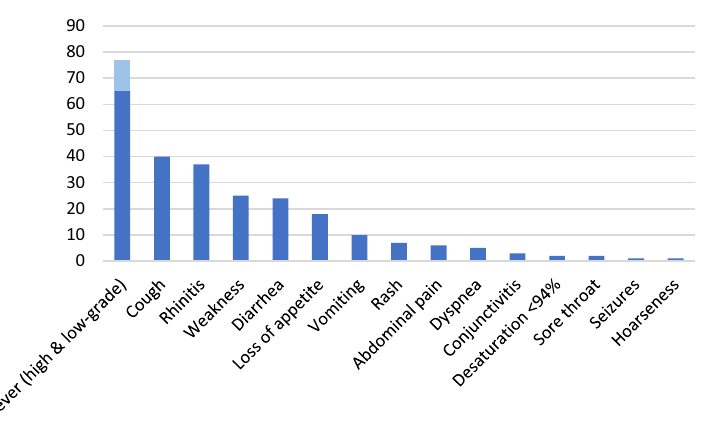
Figure 2. Clinical symptoms of COVID-19 in 300 infants. Data are presented as prevalence of the symptoms diarrhea in 73 (24%), loss of appetite in 55 (18%), vomiting in 29 (10%), rash in 21 (7%), abdominal pain in 18 (6%), and dyspnoea in 16 (5%) (Fig. 2). Severity of disease was classified as mild 276 (97.9%), moderate 6 (2%), and severe 0. An asymptomatic course was recorded in 32 (11%) patients. Comorbidities were reported in 12% of infants, including congenital disabilities, epilepsy, prematurity, atopic dermatitis, bronchopulmonary dysplasia, and immunodeficiency (Table 1). In the analyzed laboratory test deviations, 52% (74/141) of the patients had an elevated concentration of D-dimers > 500 ng/mL, and 40% (32/80) of the cases had an elevated concentration of Interleukin-6 (IL-6) > 7 pg/ mL. Antipyretic drugs were used in 115 (38%) patients, including paracetamol in 62 (54%), ibuprofen in 12 (10%), and a combination of paracetamol and ibuprofen in 41 (36%). No infants received remdesivir, tocilizumab, or anticoagulants. Among the additional diseases found in infants with COVID-19 during the first and second waves, urinary tract infections (22/300), viral gastrointestinal infections (11/300), and otitis media (9/300) were the most fre- quently diagnosed. 183 of the 282 hospitalized children (65%) had chest radiographs; 70 (25%) had abnormal findings on the radiograph. Pulmonary lesions in CXR included patchy consolidation with lower lung distribution, peribronchial thickening, and peribronchial consolidation. Computed tomography was not performed for any infant. Based on clinical symptoms and chest X-ray examination, pneumonia was diagnosed in the course of SARS- CoV-2 infection in 70 (23.3%) children. Gastrointestinal symptoms were observed in 19 (27%) of them, and 6 children with saturation < 94% required oxygen therapy. One child was treated in an intensive care unit but did not require mechanical ventilation. Boys suffered from pneumonia more often (67% vs. 33%). In the infants with pneumonia, fever above 38.5 °C was observed in 70%, a cough in 46%, and in 27% there were also gastrointestinal symptoms. In this group of infants, comorbidities occurred in 16% of the patients. Laboratory abnormalities in infants with pneumonia included elevated IL-6 levels to an average of 9.1 pg/ml, and elevated D-dimer levels to an average of 608 ng/ml. There were no statistically significant differences in C-reactive protein (CRP) concen- trations, leukocytes, IL-6, D-dimers and aminotransaminases in infants with pneumonia compared to children with COVID-19 without pneumonia. Gastrointestinal symptoms during COVID-19 occurred in 94 (31.3%) children: 53 boys and 41 girls. In 69% of the patients, gastrointestinal symptoms were accompanied by a fever above 38.5 °C. In this group of children, 11% had comorbidities. Among infants with gastrointestinal symptoms, elevated levels of IL-6 and D-dimers were recorded, compared to children without gastrointestinal symptoms, but the differences were not statistically significant. In this group of children, there were no increases in concentrations of CRP, leukocytes or aminotransaminases. No statistically significant differences were observed in CRP levels, leukocytes and alanine aminotransferase (ALT) activity compared to the group of children without gastrointestinal symptoms. The courses of COVID-19 in children diagnosed during the first and second waves of the pandemic were compared. During the second wave of the pandemic, 6 times more children under 1 year of age were hospitalized (242 vs 40, p = 0.0001). In addition, children were statistically significantly younger compared to the patients during the first wave ( p < 0.0001). Children hospitalized during the second wave had significantly less frequent household contacts with infected family members (53% vs 90%). During the second wave, infants were also hospitalized for significantly longer ( p < 0.0001), (Table 2). Children hospitalized in the second wave of the pandemic more often developed fever ( p = 0.008), weakness ( p = 0.02), and decreased appetite ( p = 0.01), (Table 3). When analyzing the results of studies in particular periods of the epidemic, statistically significant higher procalcitonin (PCT) concentration ( p = 0.002), and decreased concentrations of Hemoglobin (Hgb) and Red blood cells (RBC) p = 0.01 vs p = 0.02, were observed more often